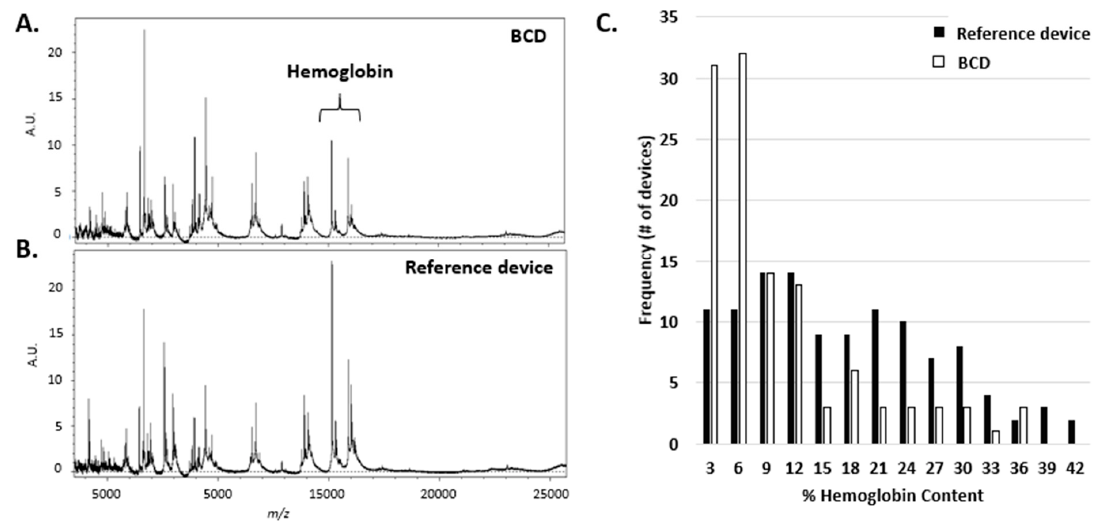
Figure 2. Typical matrix assisted laser desorption / ionization-time of flight (MALDI-ToF) mass spectra of the separated liquid fraction obtained from A. the blood-collection device (BCD) and B. Reference device (HemaSpot-SE). C. Histogram of the percentage spectral hemoglobin content for each of the devices (n = 112, bin size is 3%) obtained in the concordance study. The histogram counts the number of devices that were received that fall within a defined range of spectral hemoglobin